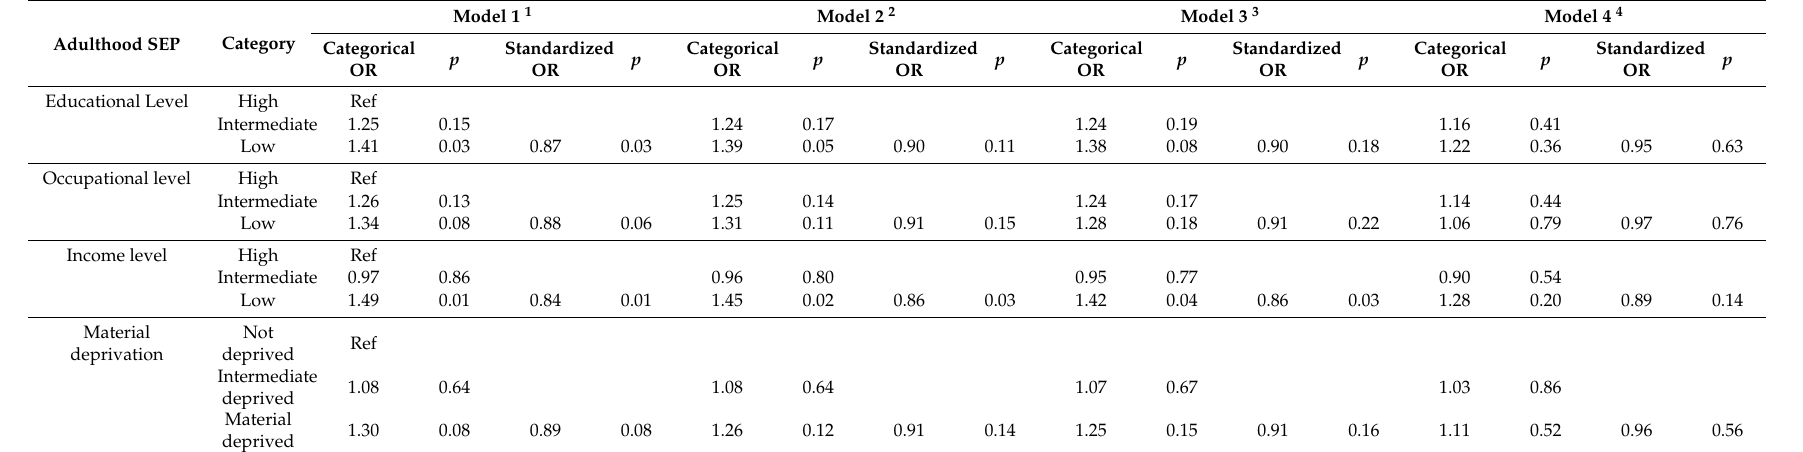
Table 2. Odds ratios of prediabetes by educational level, occupational level, income level and material